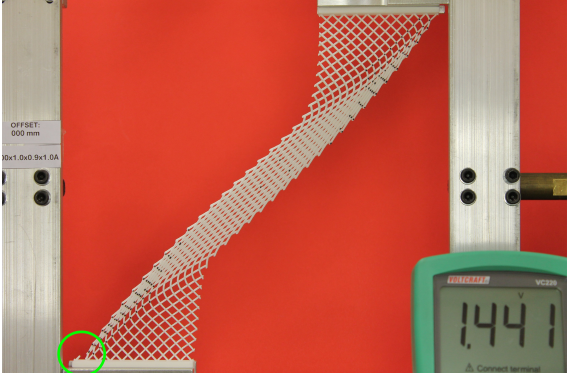
Figure 12. Deformed sample A directly after first failure occurs, region marked by the circle.